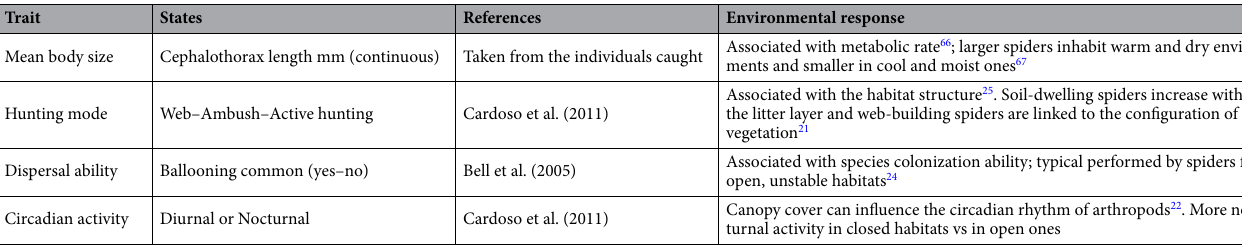
from 10 points taken randomly, and the litter depth in the middle of each quadrant. We calculated vegetation density in the lower stratum using a digital camera positioned approximately 1 m from a white cloth of 1 × 1 m used as a background screen and we took a picture capturing the vegetation in the meedle 33 . We estimated the percentage covered by vegetation by transforming the photographs into black for vegetation and white for back- ground screen, and quantifying them with the ImageJ program 34 . Spider sampling and identification. Spiders were sampled using pitfall traps to collect ground mobile spiders and an entomological vacuum (G-vac) method to catch less mobile ones from the herbaceous strata 35 . At each study site (sample unit) three pitfall traps (diameter = 9 cm, depth = 10 cm) were placed 10 m apart from each other 36 . Traps were half filled with propylene glycol and water (30:70). A plastic roof was placed 10 cm above the trap to prevent flooding and evaporation 37 . Pitfall traps worked for 6 weeks, 3 in spring (November 2015) and 3 in summer (January 2016). The G-vac method was used to suck spiders from the herbaceous strata in a 1 × 1 m square for 1 min using a vacuum with a 110 cm long and 12 cm wide tube. On each site and sam- pling period we collected five subsamples diurnally and separated at least by 10 m 38 . The material per site was pooled together and conserved in ethanol 70%. Adult spiders were identified to species or morphospecies using taxonomic keys and assistance of arachnologists from the “Museo Argentino de Ciencias Naturales Bernardino